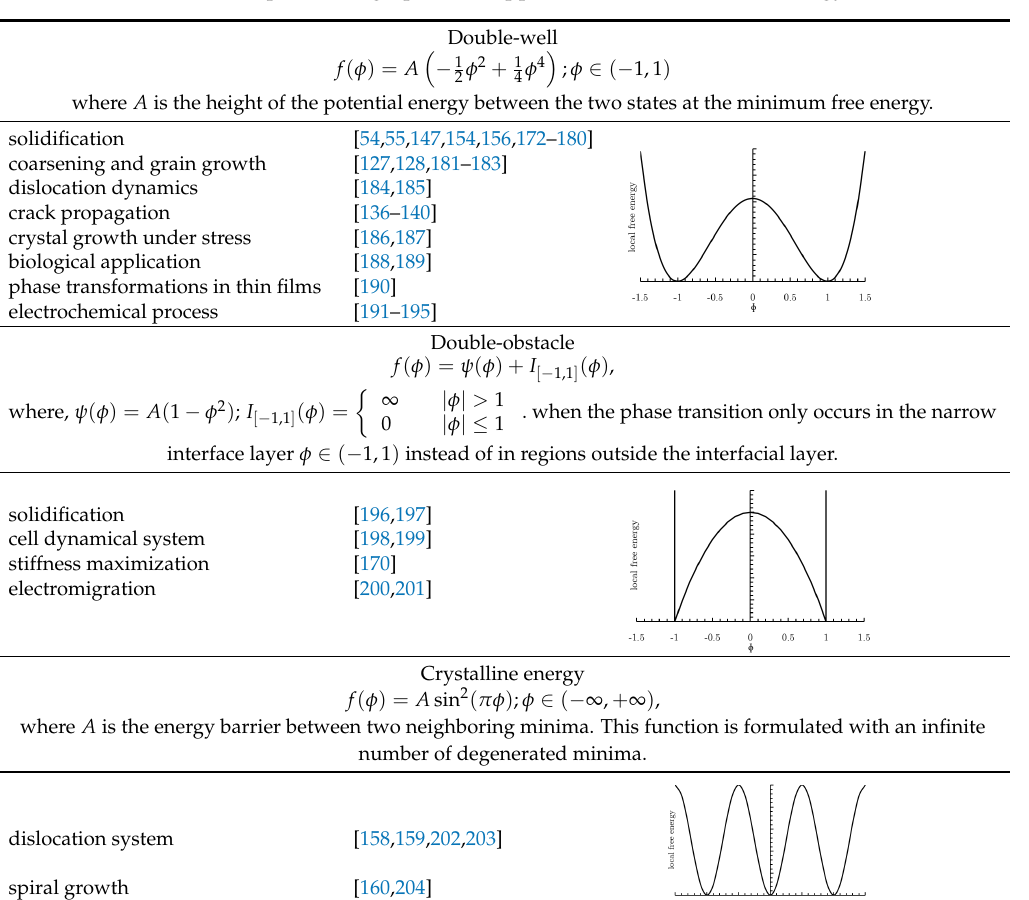
Table 1. Expressions, graphs, and applications of the local free